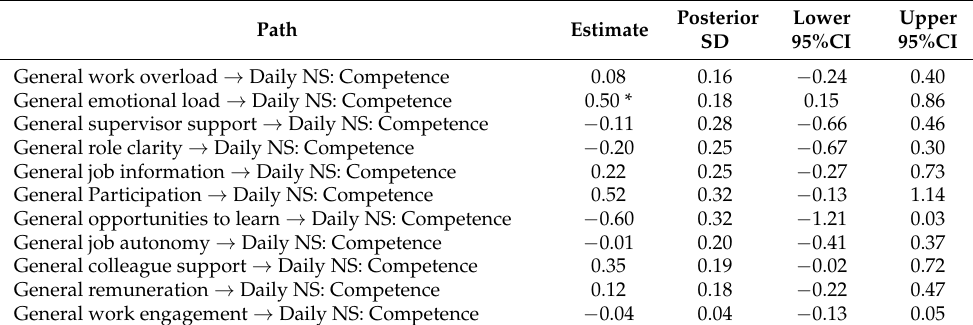
Table 4. Estimates with 95% credible